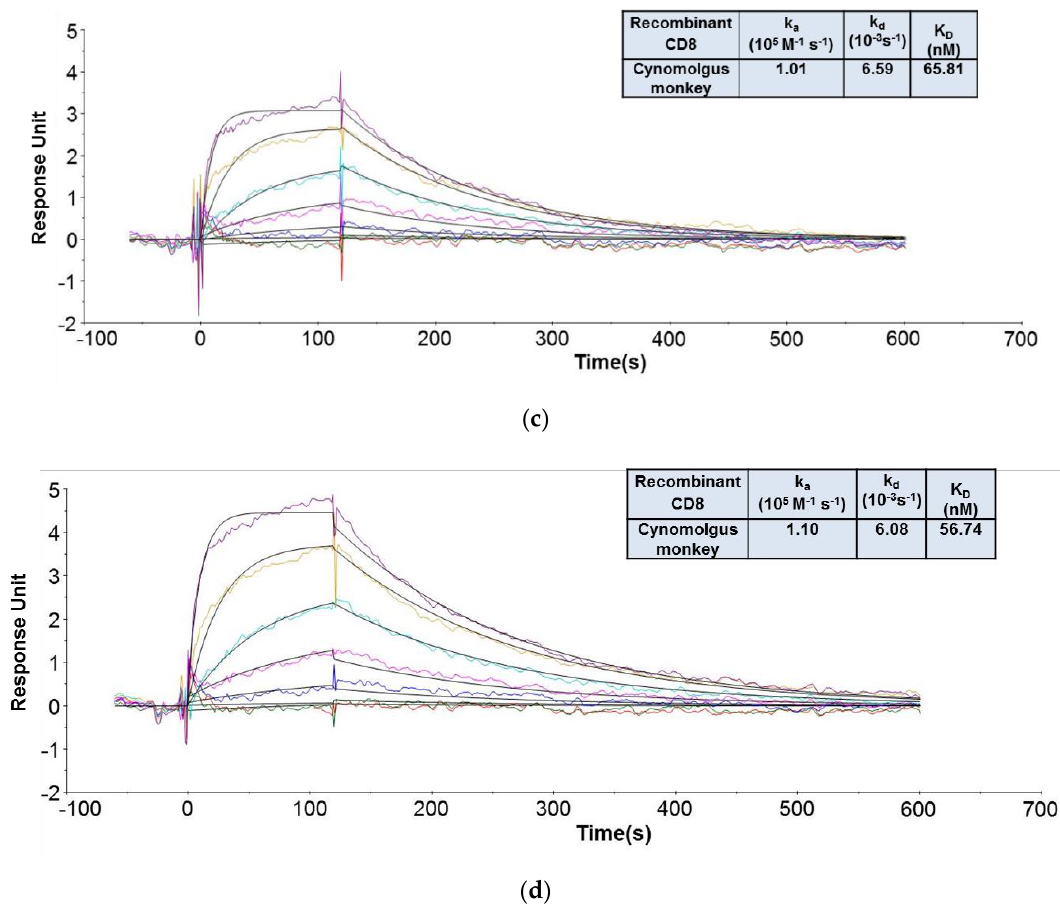
Figure 5. Representative sensorgrams of concentration-dependent binding of the recombinant human CD8 to CED8 [56] ( a ) and RED8 ( b ), and recombinant cynomolgus monkey CD8 to CED8 ( c ) and RED8 ( d ) at 37 °C. Note: Black solid lines are fitted curves using a 1:1 binding model and colored lines are the actual data. Concentrations of the recombinant human CD8 protein (from bottom to top in the upper panel) are 1.23, 3.70, 11.1, 33.3, 100, and 300 nM. Concentrations of the recombinant cynomolgus monkey CD8 protein (from bottom to top in the upper panel) are 1.23, 3.70, 11.1, 33.3, 100, 300, and 900 nM. Sensorgrams were generated after in-line reference cell correction followed by buffer sample subtraction. The kinetics and affinity data in the table in 5a, 5b, 5c, and 5d were averaged from 3, 2, 6, and 5 independent experimental SPR runs, respectively.